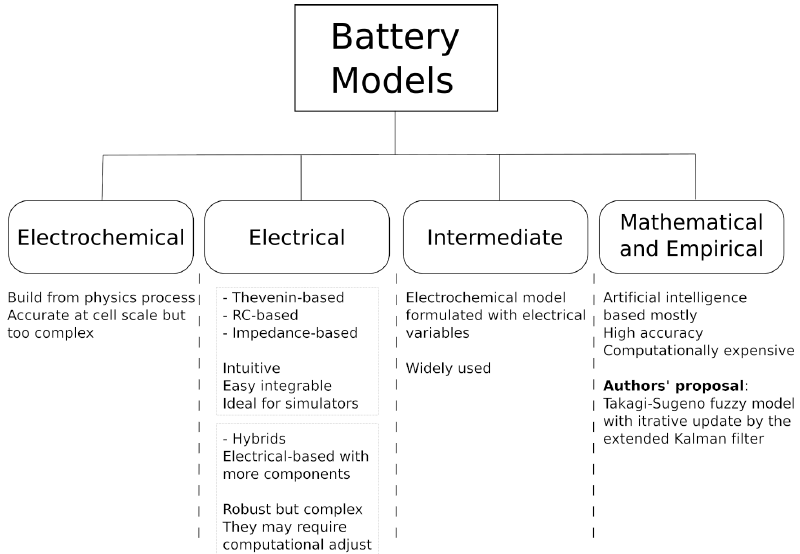
Figure 1. Brief classification of battery